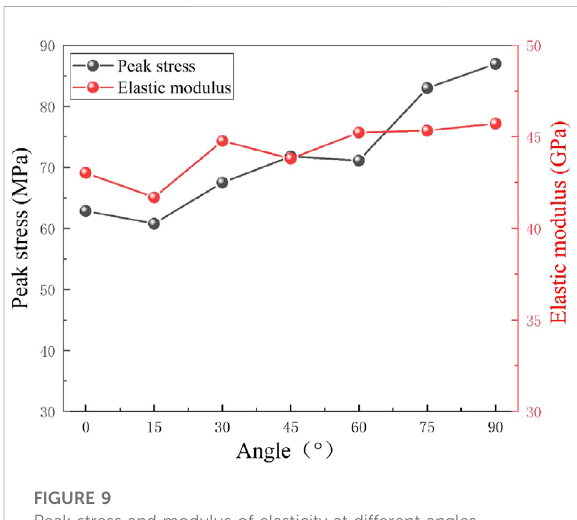
FIGURE 9 Peak stress and modulus of elasticity at different